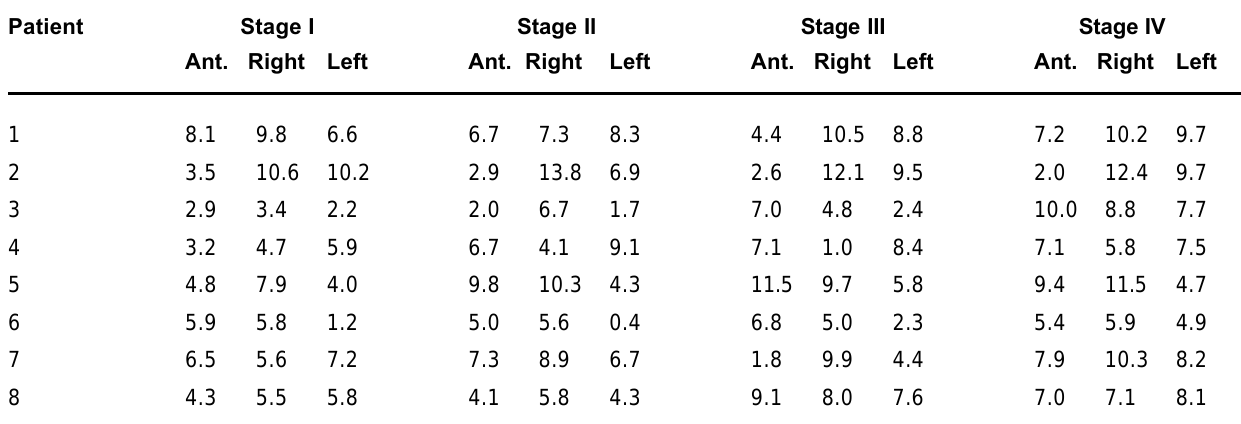
Patient Stage I Stage II Stage III Stage IV Ant. Right